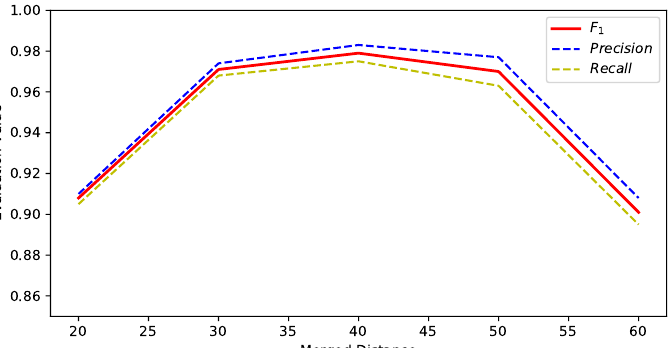
Figure 9. Precision, Recall, and F1 score under different d α over acacia and oil-palm confused dataset. We could find that, 40 of d α is the best parameter choice for the following experiments.